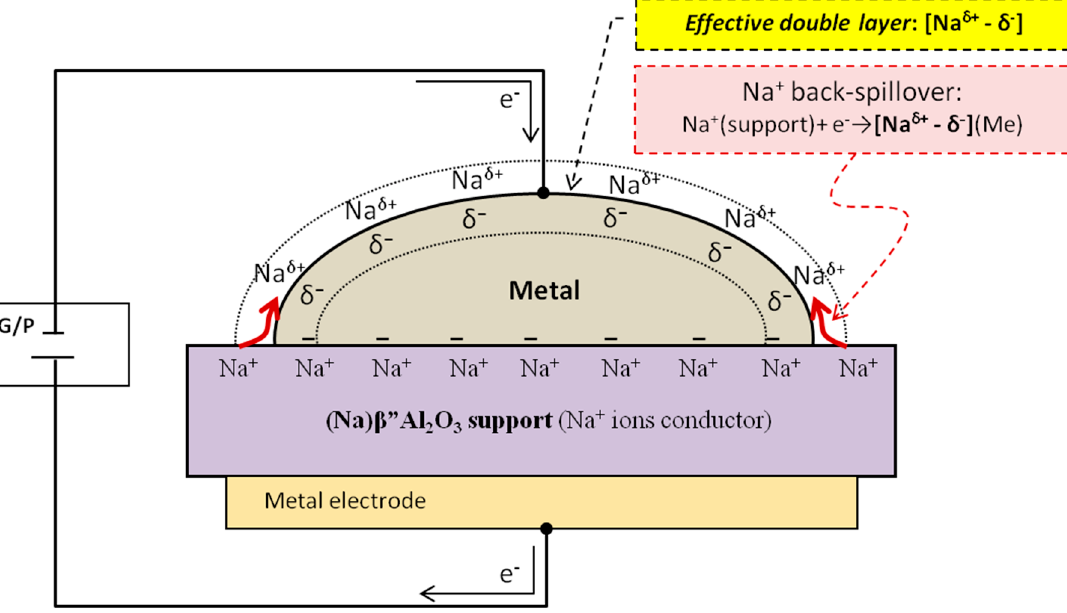
Figure 19. Schematic of the effective double layer approach of catalyst promotion [6,7,110]. An electron enriched (lower work function) catalyst surface is developed due to the uniformly dispersed Na δ + adatoms.